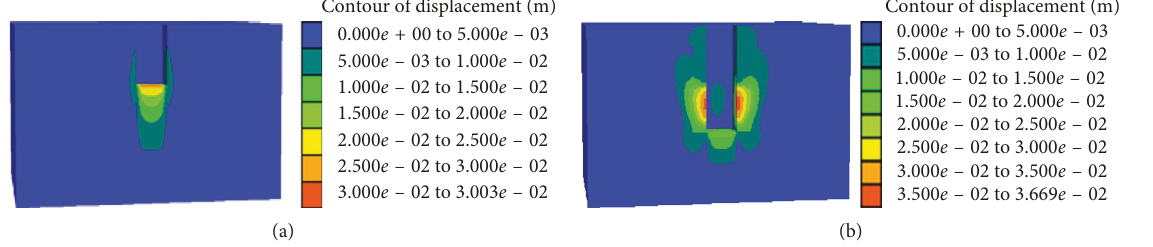
Figure 6: Soil deformation: (a) at the completion of dewatering excavation and (b) at the completion of underwater